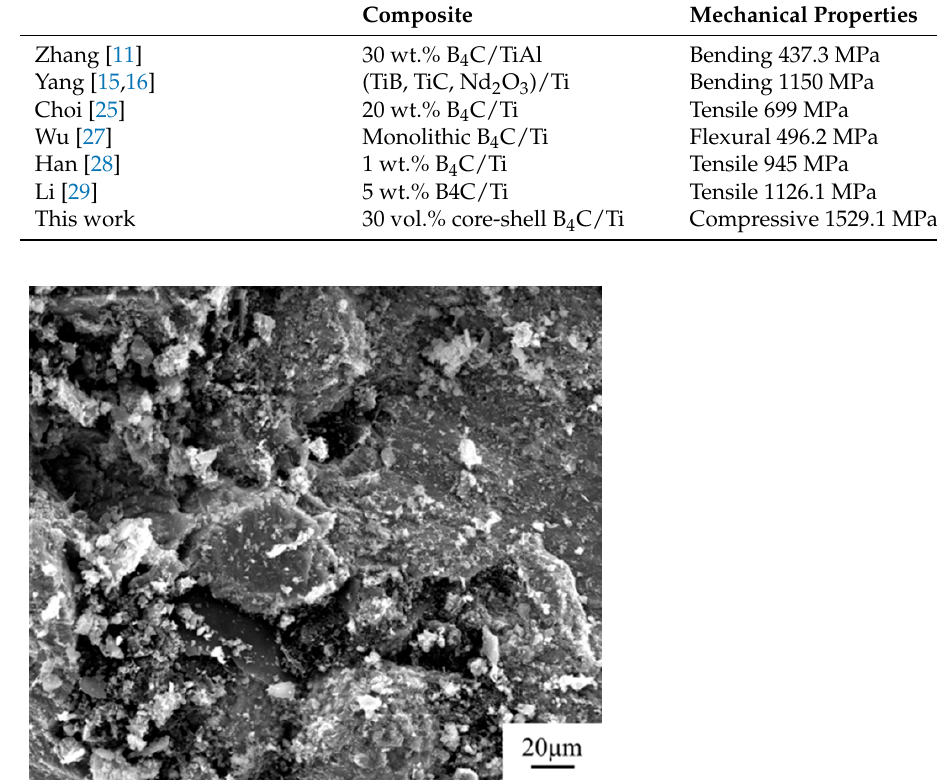
Figure 9. Compressive mechanical properties of composites with core-shell structure; ( a ) strain–stress curves; ( b ) comparison of mechanical properties (the yield strength of pure Ti is obtained from Ref. [26]). Table 1. The mechanical properties of B 4 C/Ti composites were reported.